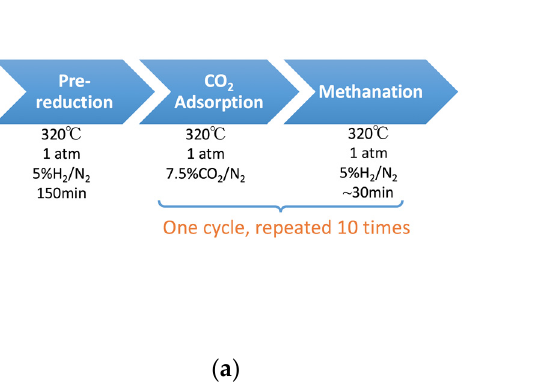
Figure 10. Process flow for the two different cyclic tests operated on the scaled-up fixed bed reactor. ( a ) O 2 - and steam-free CO 2 adsorption and hydrogenation for the 10-cycle test. Pre-reduction was utilized only once before the first cycle. The subsequent ten cycles were conducted repeatedly under identical experimental conditions; ( b ) Simulated flue gas 12-cycle test with the pretreatment used only before the first cycle followed by 10 identical cycles. A N 2 purge was needed between each cycle to avoid H 2 -O 2 contact. Before the 11th and the 12th cycle, a prolonged H 2 exposure was utilized while subsequent steps remained the same as the first ten cycles.